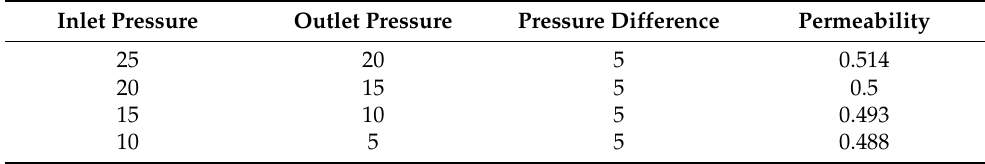
Table A1. Experimental results of salt dissolution in a core sample of Well